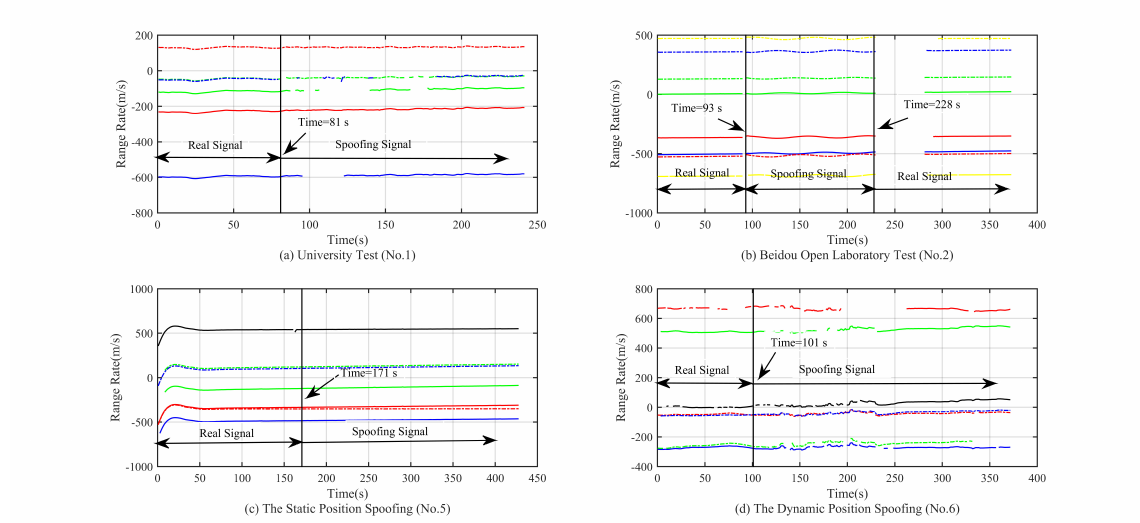
Figure 15. Curve of the range rates in different experimental scenarios.